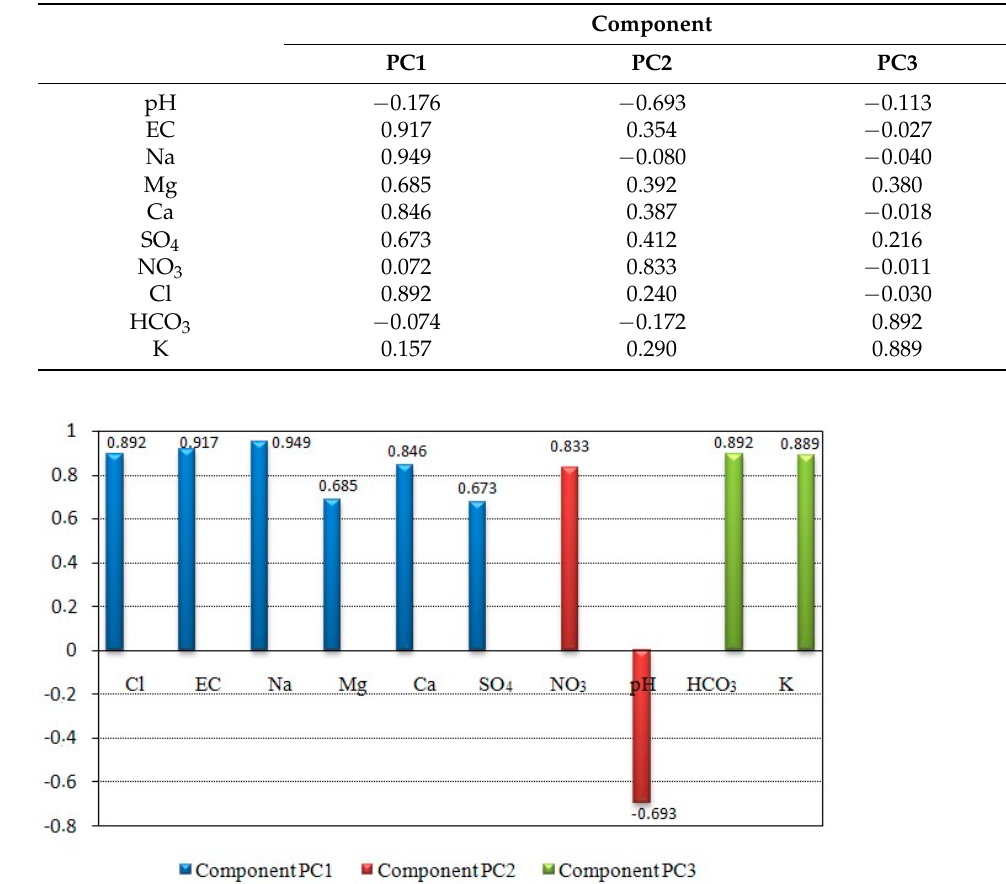
Figure 4. Correlation piezometric on HCO 3 spatial evolution in 2017 in the coastal shallow aquifer of Sfax. 3.2. Water Chemical Features Several hydrochemical studies conducted on the Sfax aquifer indicated that ground ‐ water mineralization is controlled by many factors such as evaporation, precipitation, and dissolution, which are considered to be more expressed in shallow aquifers. These phe ‐ nomena were also observed in a case study of the coastal aquifers of southern India [50] and in the case of the coastal Djeffara aquifer, southeastern Tunisia [54]. Indeed, chemical analyses conducted on the Sfax coastal shallow aquifer indicate that the groundwater is characterized by NaCl–CaSO 4 facies, which denotes an origin of mineralization from the dissolution of evaporitic minerals such as halite and gypsum–anhydrite. Furthermore, hydrochemical models carried out to understand the mechanisms of salinization variations in groundwater [55] demonstrate that basic ion exchange mecha ‐ nisms could play a role in the mineralization of water in the shallow aquifer of the Sfax